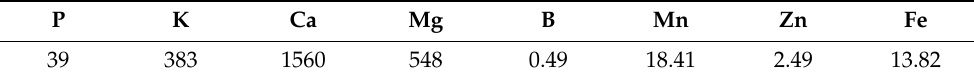
Table 1. Soil nutrient concentrations (mg kg − 1 ) of the experimental orchard. P